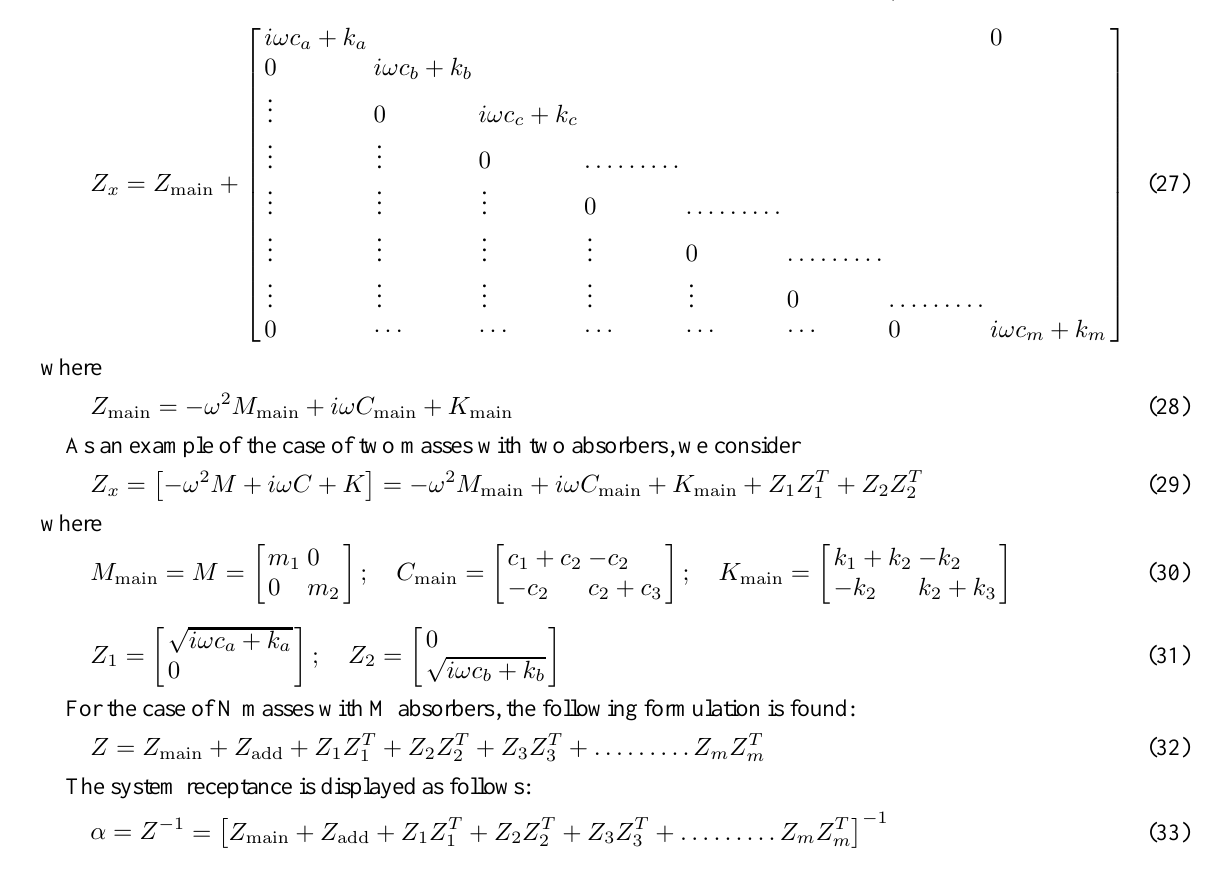
Fig. 10. Displacement of main mass 2, goal function is (0.2x 1 + 0.8x 2 )